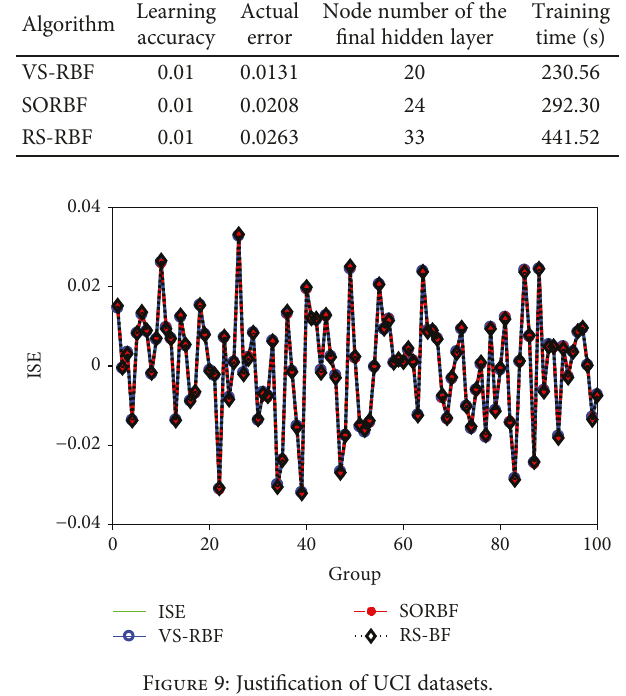
Table 2: Comparisons of performances in UCI datasets. Learning Algorithm accuracy